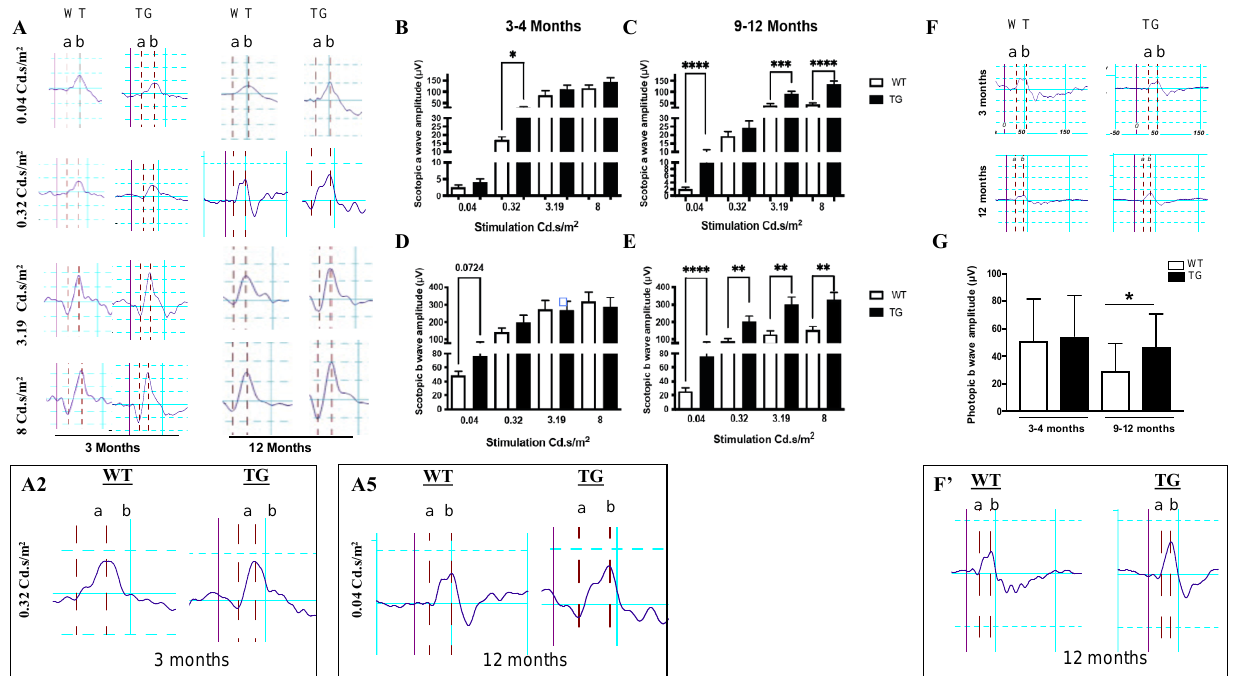
Figure 2. Functional assessment of the retinal alterations in APP/PS1 mice . ( A ) Representative a– and b–waveforms of scotopic ERG recorded from 3 and 12 month old WT and TG female mice (F). (A2: enlargement corresponding to the 2 nd WT/TG ERG traces example, i.e. 2 nd line in the 3 Months row for the indicated light intensity) Scotopic ERG representative data of 3 month old WT and TG F–mice in response to a flash stimulation at 0.32 Cd.s/m 2 . (A5: corresponding to the 5 th WT/TG ERG traces example, i.e. 1 st line in the 12 Months row for the indicated light intensity) Scotopic ERG representative data of 12 month old WT and TG F–mice in response to a flash stimulation at 0.04 Cd.s/m 2 ( B , C ) WT (white bars) and TG APP/PS1 (black bars) mice ERG, in response to 0.04; 0.32; 3.19 and 8 Cd.s/m 2 light stimulus intensities corresponding to the rod photoreceptors a–wave amplitude quantification. ( D , E ) Inner retinal function assessment by b–wave amplitude quantification. ( F ) Representative of photopic ERG recorded from 3 and 12 month old WT and TG F-mice. ( F’ ): Photopic ERG representative recorded of 12 month old WT and TG mice. ( G ) WT (white bars) and TG APP/PS1 (black bars) mice photopic ERG, corresponding to the cone photoreceptors recorded. For scotopic and photopic ERG recordings, a total of n= 15 WT (n= 7 males (M) + 8F) and n = 13 TG APP/PS1 (n= 6M + 7F) were used. Mice from the WT and TG cohort were used at between 3–4 months (n= 7M + 8F WT and n = 6M + 7F TG) and at 9 months (n= 4M + 4F WT and n = 3M + 3F TG) or 12 months (n= 3M + 4F WT and n= 3M + 4F TG). Results are expressed as mean +/− SEM. WT= non-transgenic, wild-type; TG= transgenic APP/PS1. * p < 0.05, ** p < 0.005, *** p < 0.001, **** p < 0.0001.